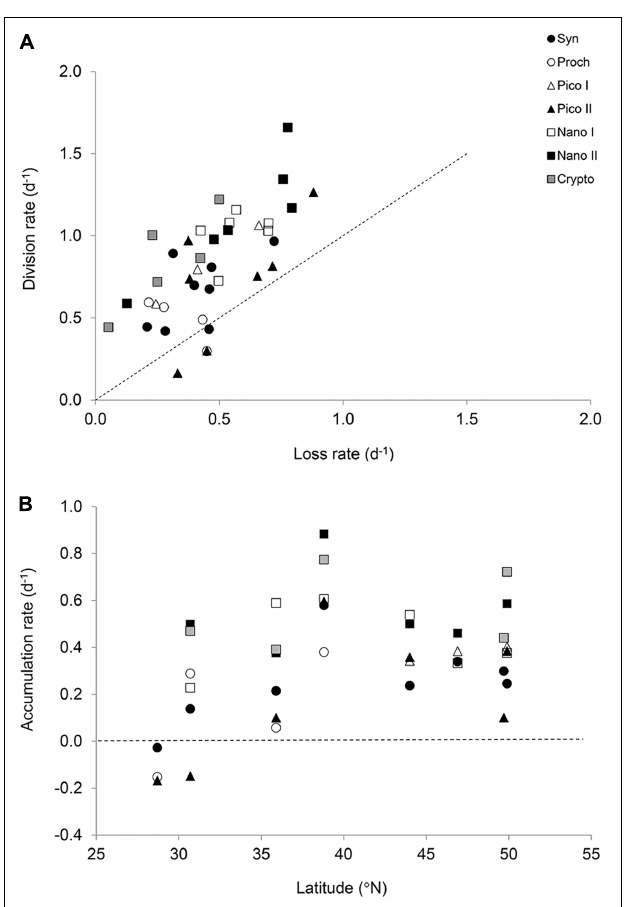
FIGURE 3 | The balance between division and loss rates of the seven phytoplankton groups ( < 20 µ m). (A) Relationship between the total loss rate (grazing + viral lysis) and gross growth rate of phytoplankton obtained from the modified dilution method. The dotted line indicates a 1:1 relationship. (B) Accumulation rates (i.e., µ – l ) of phytoplankton across the latitudinal transect. The dotted line indicates no net accumulation.